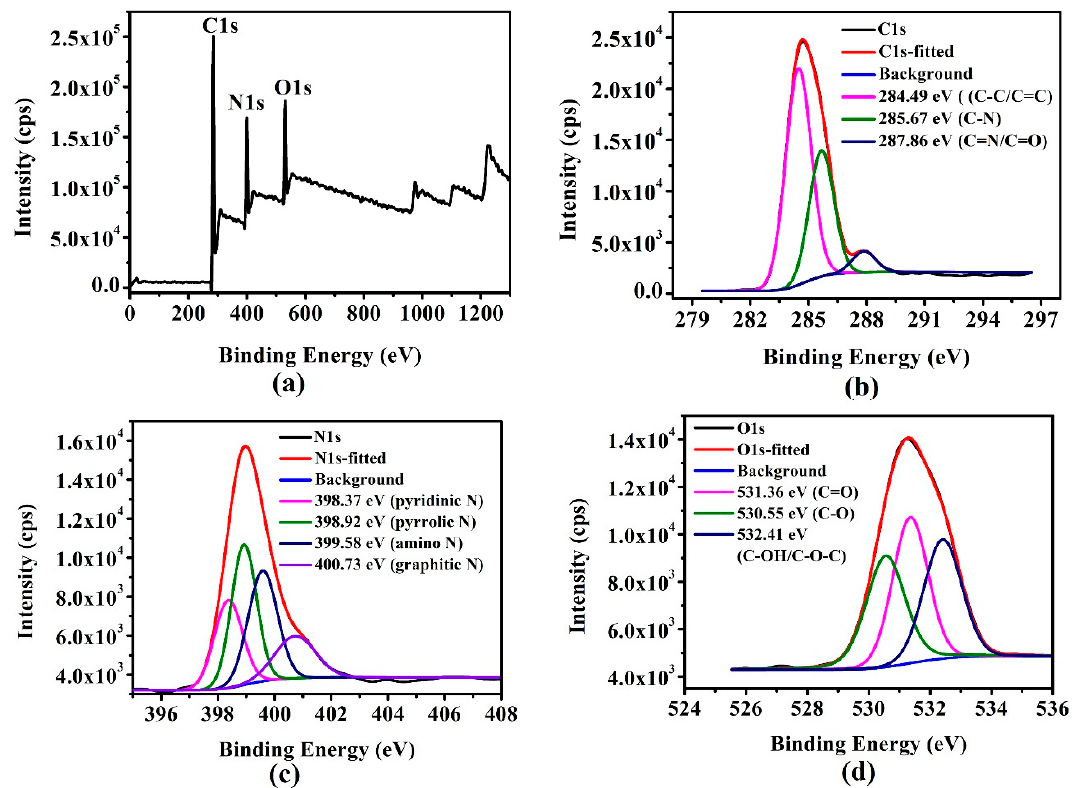
Figure 5. ( a ) X-ray photoelectron spectroscopy (XPS) spectrum of the g-CQDs, and ( b – d ) are the corresponding extended peaks of C1s, N1s and O1s, respectively (V (EDA) = 4 mL, T = 180 °C, D r = 12 h).